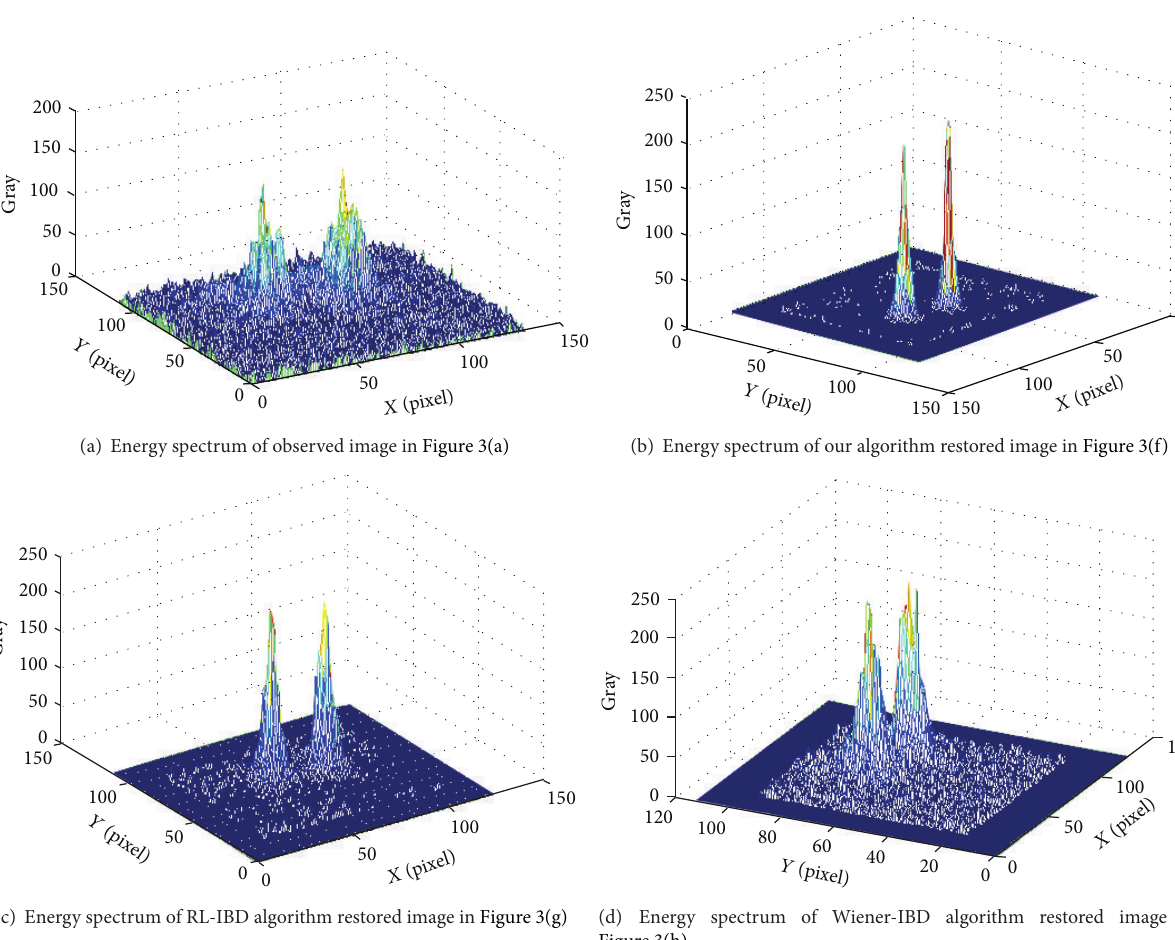
(c) Energy spectrum of RL-IBD algorithm restored image in Figure 3(g) (d) Energy spectrum of Wiener-IBD algorithm restored image in Figure 3(h) Figure 4: Energy spectrum of observed image and restoration comparison of three